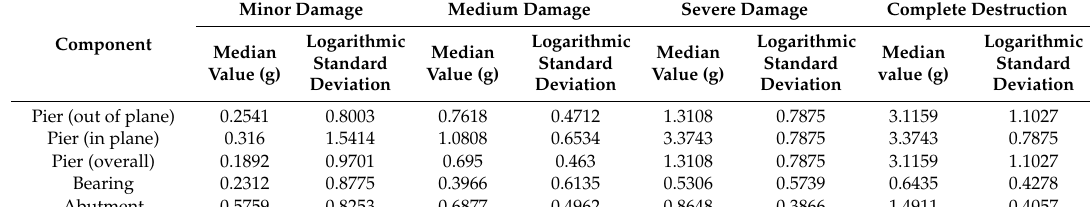
and bridge systems to di ff erent damage states.